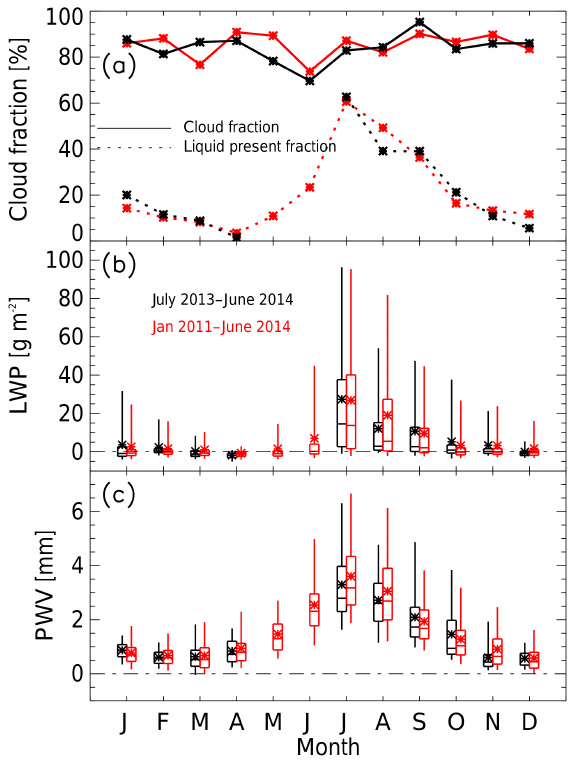
Figure 4. (a) MMCR derived cloud fraction (solid) and MWR de- rived liquid present fraction (dotted, LWP > 5gm − 2 ), (b) liquid water path, and (c) precipitable water vapor. Statistics shown in black (red) are for available data spanning July 2013–June 2014 (January 2011–June 2014). Distributions are represented by box- and-whisker plots (the box indicates the 25th and 75th percentiles, the whiskers indicate 5th and 95th percentiles, the middle line is the median, and the ∗ is the